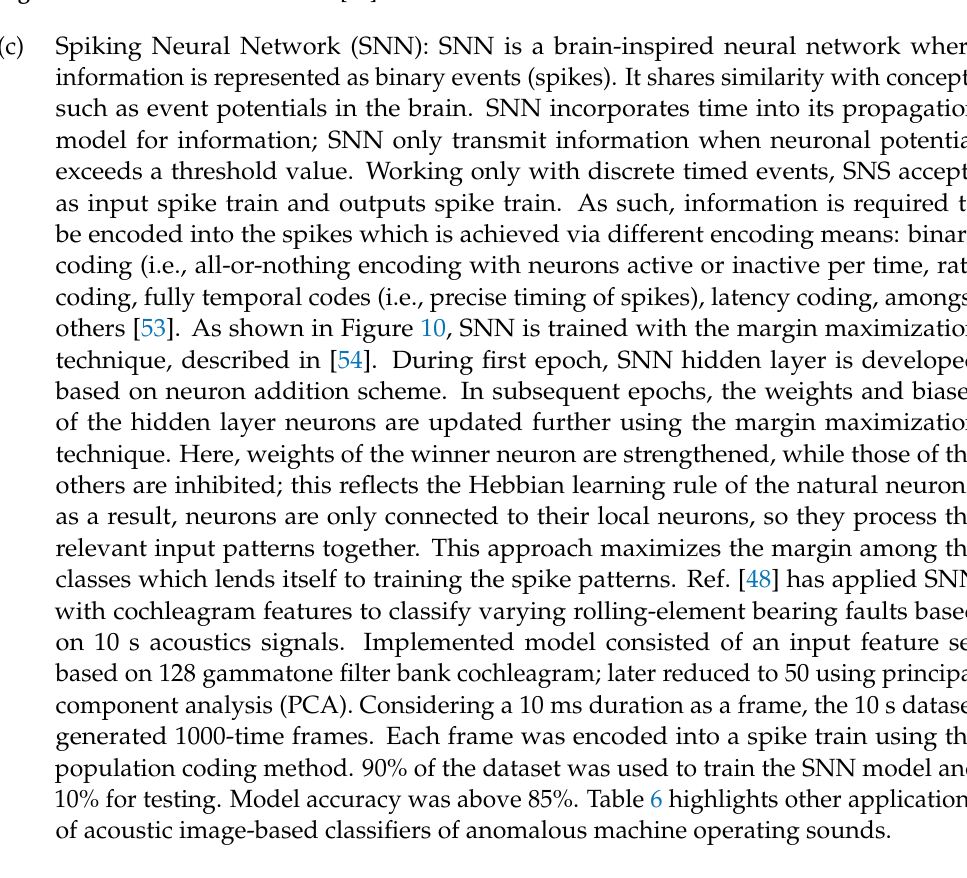
Figure 9. LSTM RNN architecture [52].